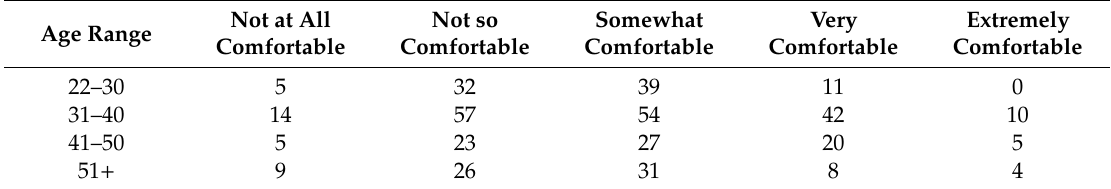
Table 7. Level of comfort integrating mRehab technology into respondent practice, by age range (number of respondents).